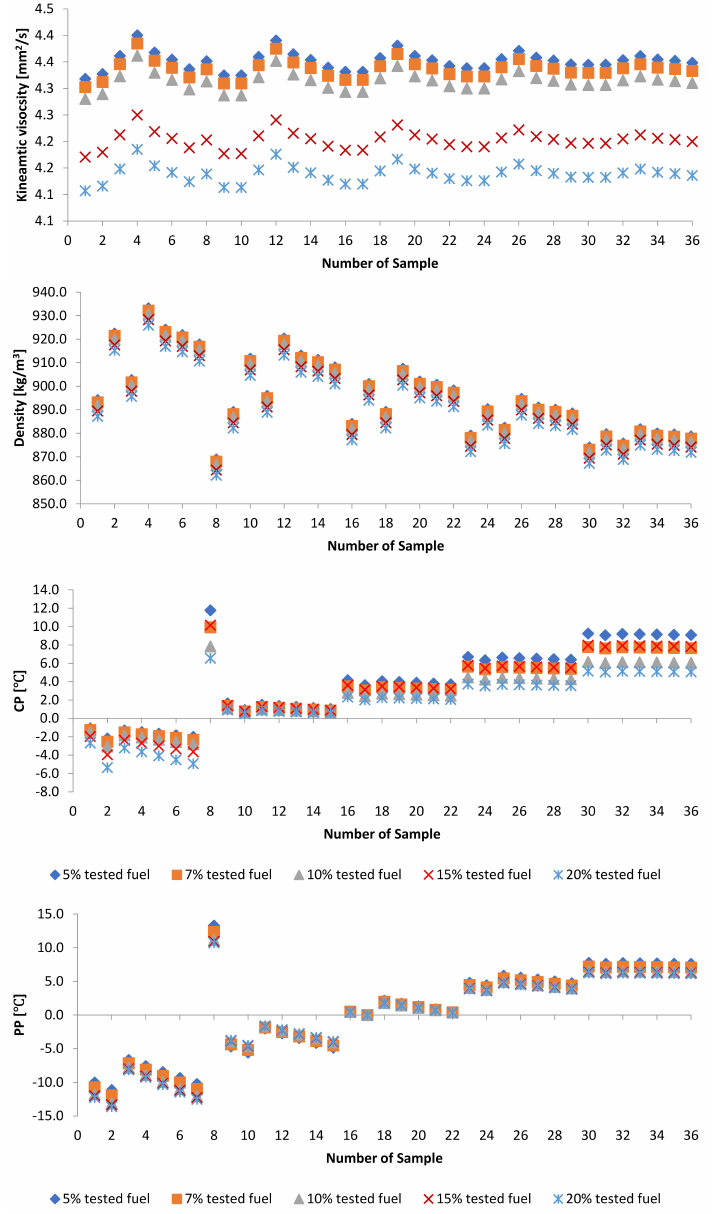
Figure 10. Properties of WFME-PME-ULSDFW with various volume